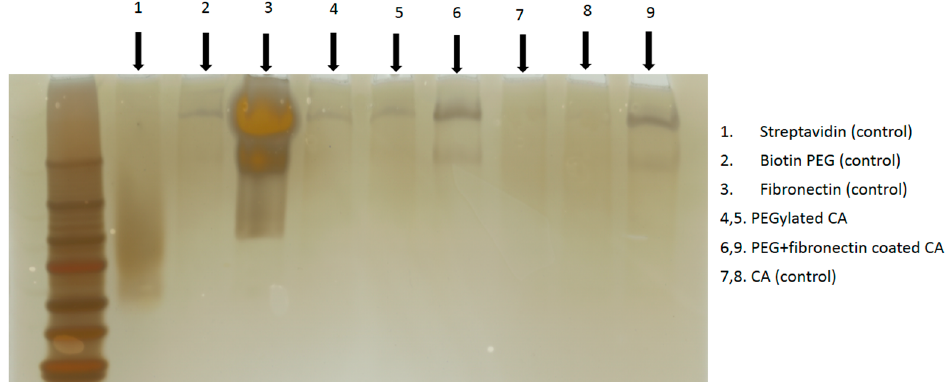
Figure 3. After formation of surface-modified CA as described above, centrifugation was done at 4 °C with 13,000 rpm for 15 min. The supernatant was discarded and the pellet was resuspended at 100 μ L DMEM. Six microliters of samples and loading dye with 1:1 ratio were loaded into each gel well (BioRad Precast Gels 7.5%) and run through SDS PAGE at 60 V for 1 h. The resulting gel was processed through silver staining.